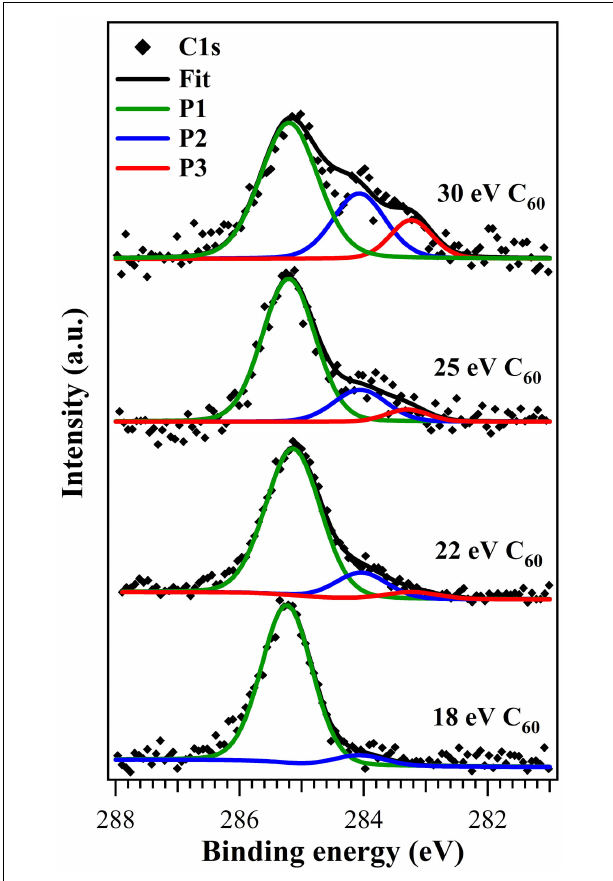
FIGURE 2 | C1s core level spectra (normalized in height) of submonolayer films grown at C 60 kinetic energies of 18, 22, 25, and 30eV . Green component corresponds to physisorbed fullerenes, blue component to chemisorbed cages, and red component to broken fullerenes and formation of silicon